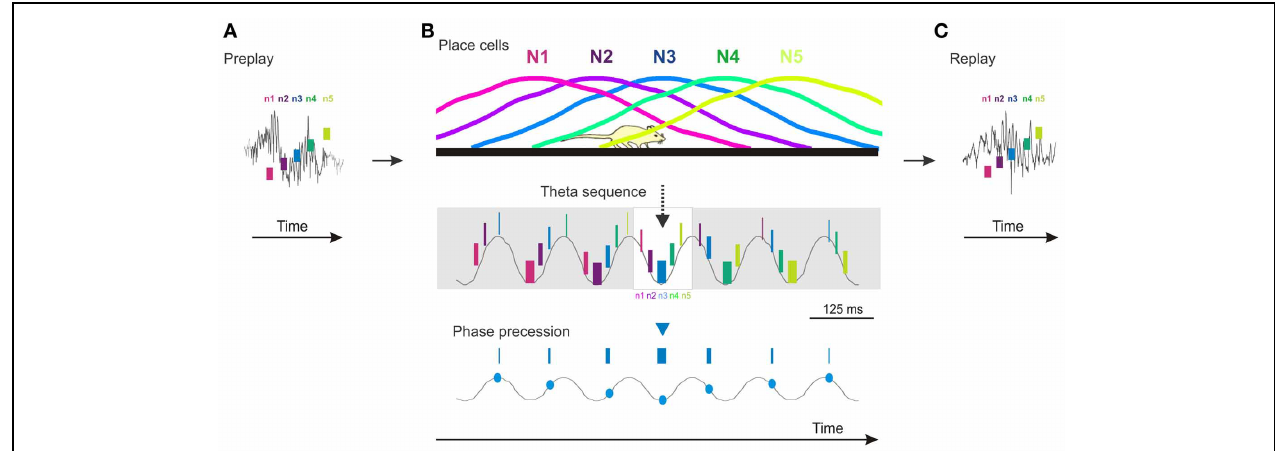
FIGURE 1 | Cartoon model of preplay, theta sequences, phase precession, and replay in the CA1 area of the hippocampus. (A) Preplay of a future novel place cell sequence during a ripple event (gray line) occurring during sleep/rest (n1–n5, five neurons firing in temporal order; short vertical bars denote relative firing of neurons in time). (B) Top, place cell sequence of the five neurons (N1–N5) in (A) firing in the same order in space during run on a novel track. Middle, temporal sequences of firing of the five neurons (n1–n5) during theta oscillation (gray line) during the run. Neurons are color coded; the thickness of the short vertical bars denote relative firing rate, highest on the theta troughs. The sequence represented in the white